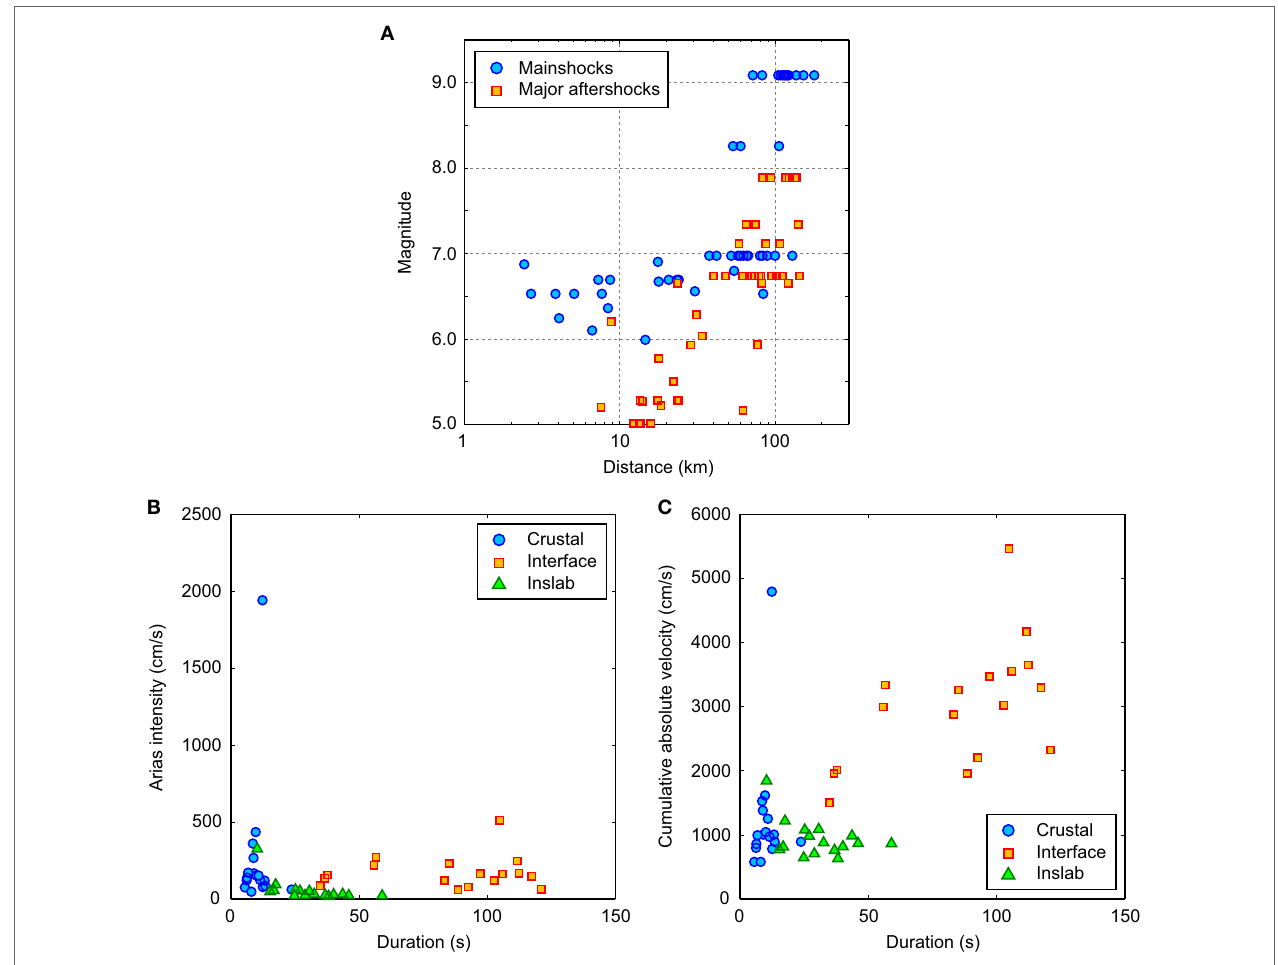
FIGURE 4 | (A) Magnitude–distance distribution of mainshocks and major aftershocks of the selected ground motion sequences. (B) Duration–Arias intensity distribution of the selected mainshock ground motion records. (C) Duration–cumulative absolute velocity distribution of the selected mainshock ground motion records.